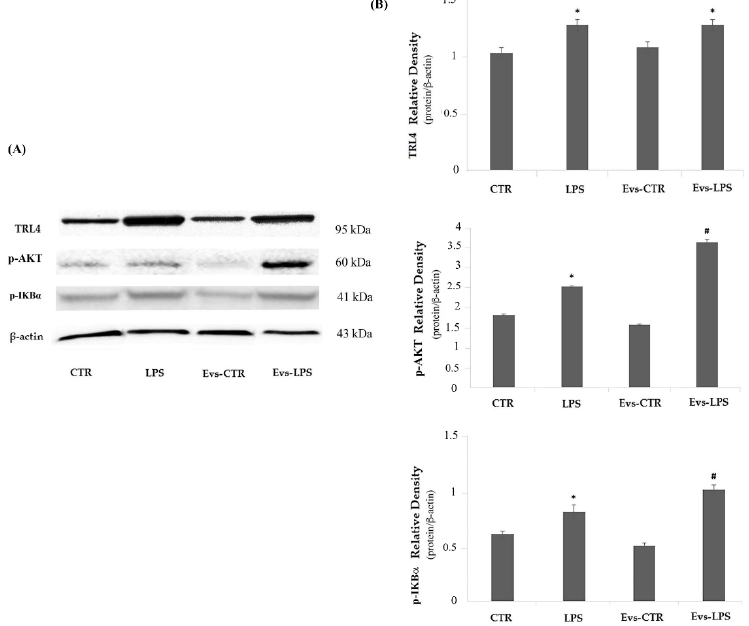
Figure 8. Panel ( A ) Western blotting detection of TLR4, p-AKT and p-IKB α in untreated cells (CTR), cells stimulated with LPS, EVs-CTR, and EVs-LPS. Panel ( B ) Densitomentric analysis of expression levels of TLR4 ( B upper), p-AKT ( B middle) and p-IKB α ( B lower). * p -value < 0.05 compared to CTR; # p -value < 0.05 compared to LPS; # p -value < 0.05 in comparison to LPS. Protein expression levels were normalized to β -actin, and the results of densitometric analysis are expressed as the mean ± SD of five independent experiments.